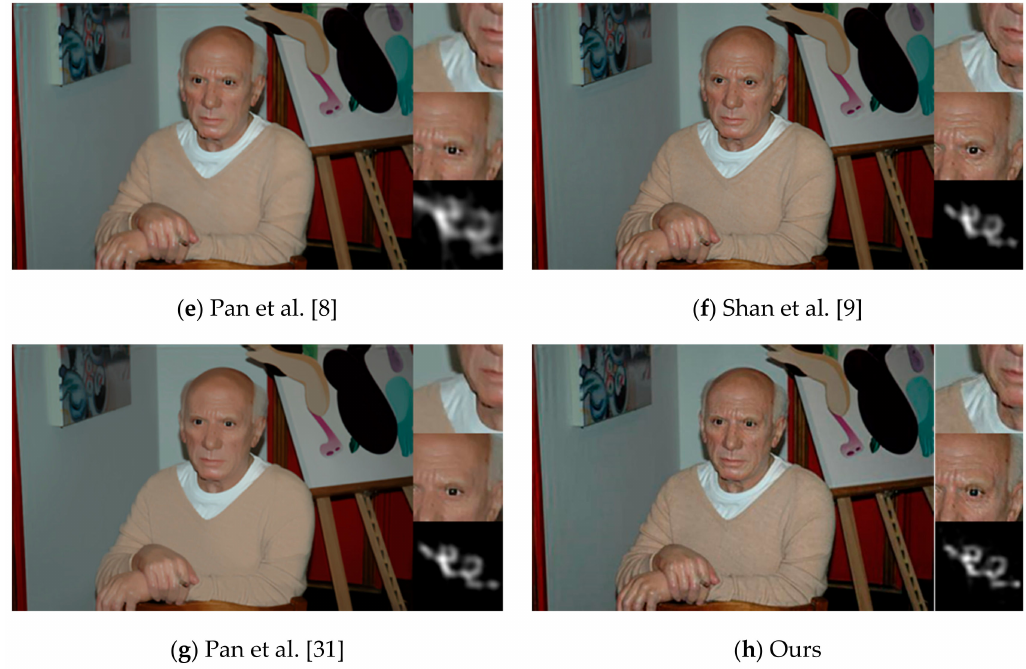
Figure 14. The deblurring results comparison of natural blurred image.